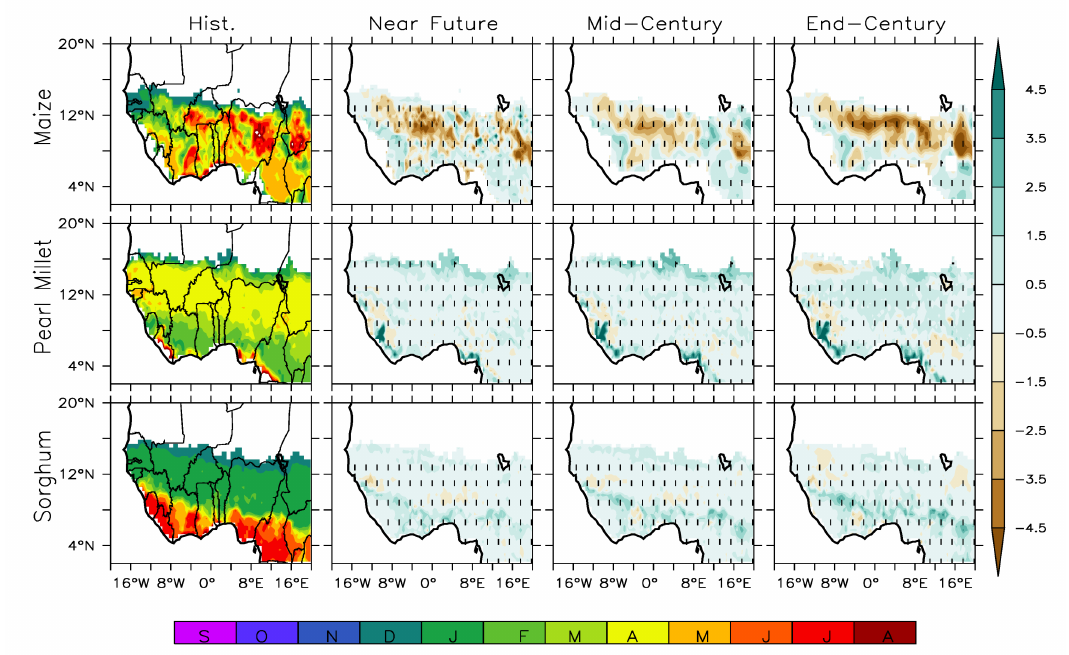
Figure 7. Simulated month of planting for cereals, maize, pearl millet and sorghum over West Africa for the historical month (1981–2000) (column 1) and the projected change in the crop planting month for the near future month (2031–2050), mid-century (2051–2070) and end of century (2081–2100) (column 2–4 respectively). The planting is simulated from September to August. The vertical strip ( | ) indicates where at least 80% of the model simulations agrees on the projected sign of change while the horizontal strip ( − ) indicates where at least 80% of the model simulations agree that the projected change is statistically significant at 99% confidence level. The cross ( + ) indicates where the two conditions are met, meaning that the change is robust.